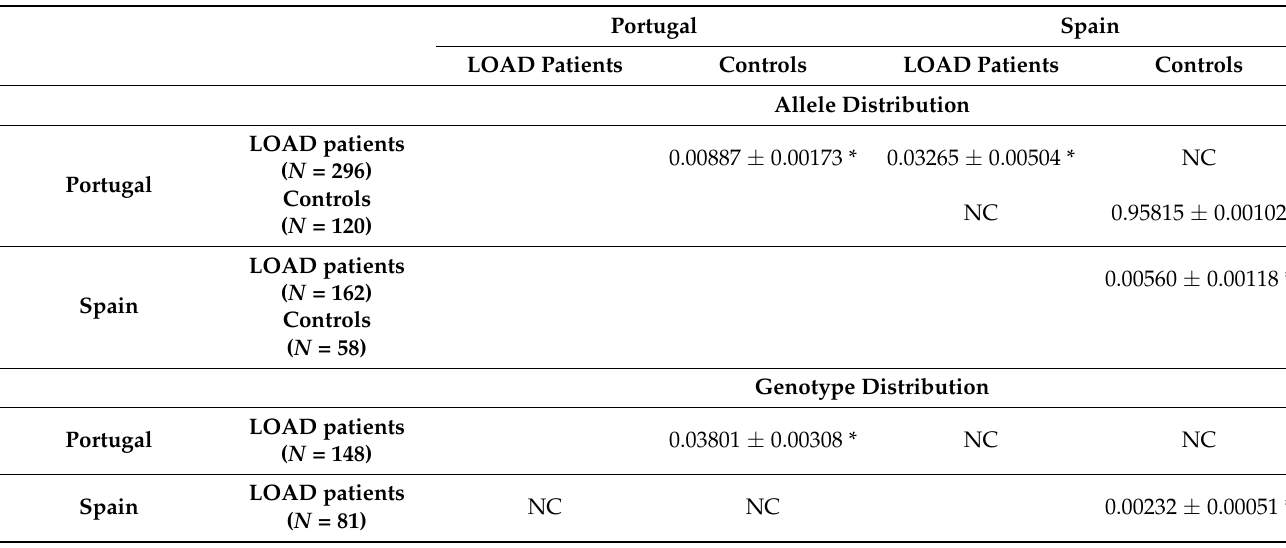
Table 3. Apolipoprotein E ( APOE ) allelic and genotypic differences of late onset Alzheimer’s disease (LOAD) patients versus controls for Portuguese and Spanish cohorts. For allele distribution, we also tested differences of Portuguese versus Spanish for cases and controls. Significant p -values ± SD ( α = 0.05) obtained from exact tests of differentiation are marked with an asterisk. After finding differences on APOE allele frequencies between Portuguese and Spanish patients ( P = 0.03265), we have not performed further interpopulation analyses (marked in the table as NC: not calculated). N : Number of individuals or alleles when APOE genotypes or APOE alleles are analyzed, respectively.